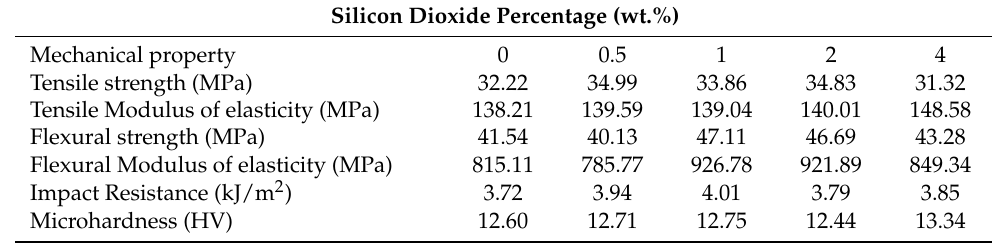
Table 1. Summarizing of mechanical properties measured and/or calculated through tests conducted.